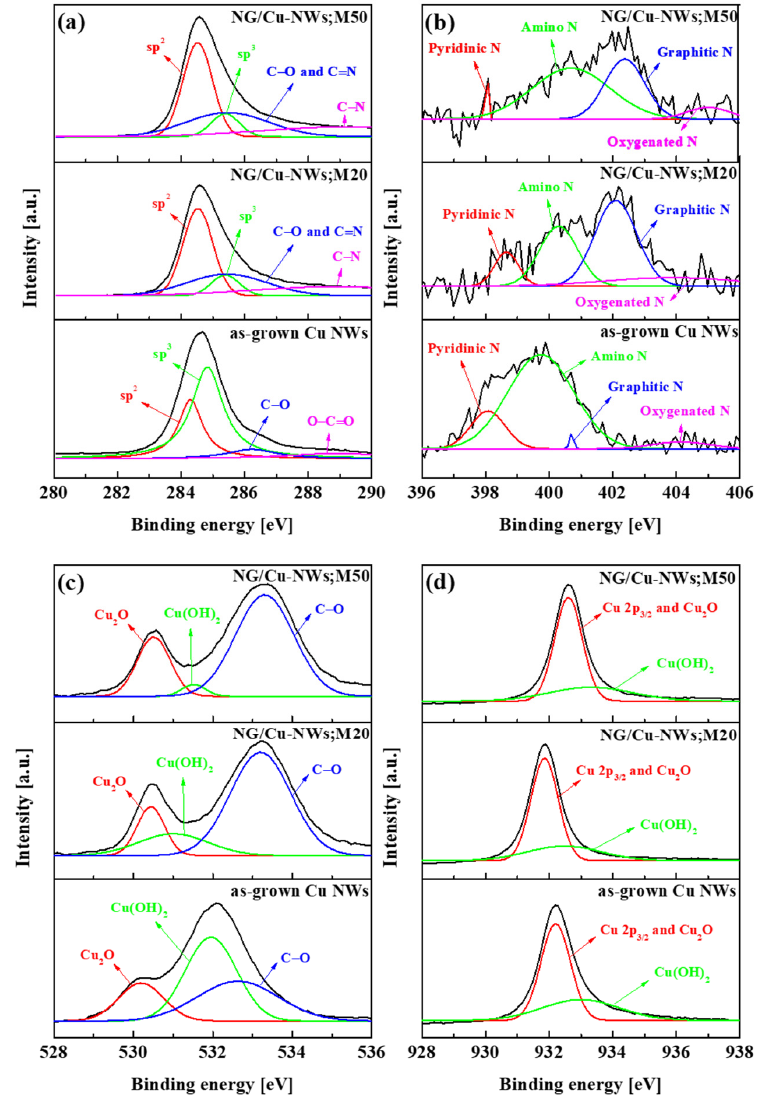
/ Cu NWs;M20, and NG / Cu NWs;M50: Figure 4. XPS spectra of as-grown Cu NWs, NG/Cu NWs;M20, and NG/Cu NWs;M50: high-resolution Figure 4. XPS spectra of as-grown Cu NWs, NG